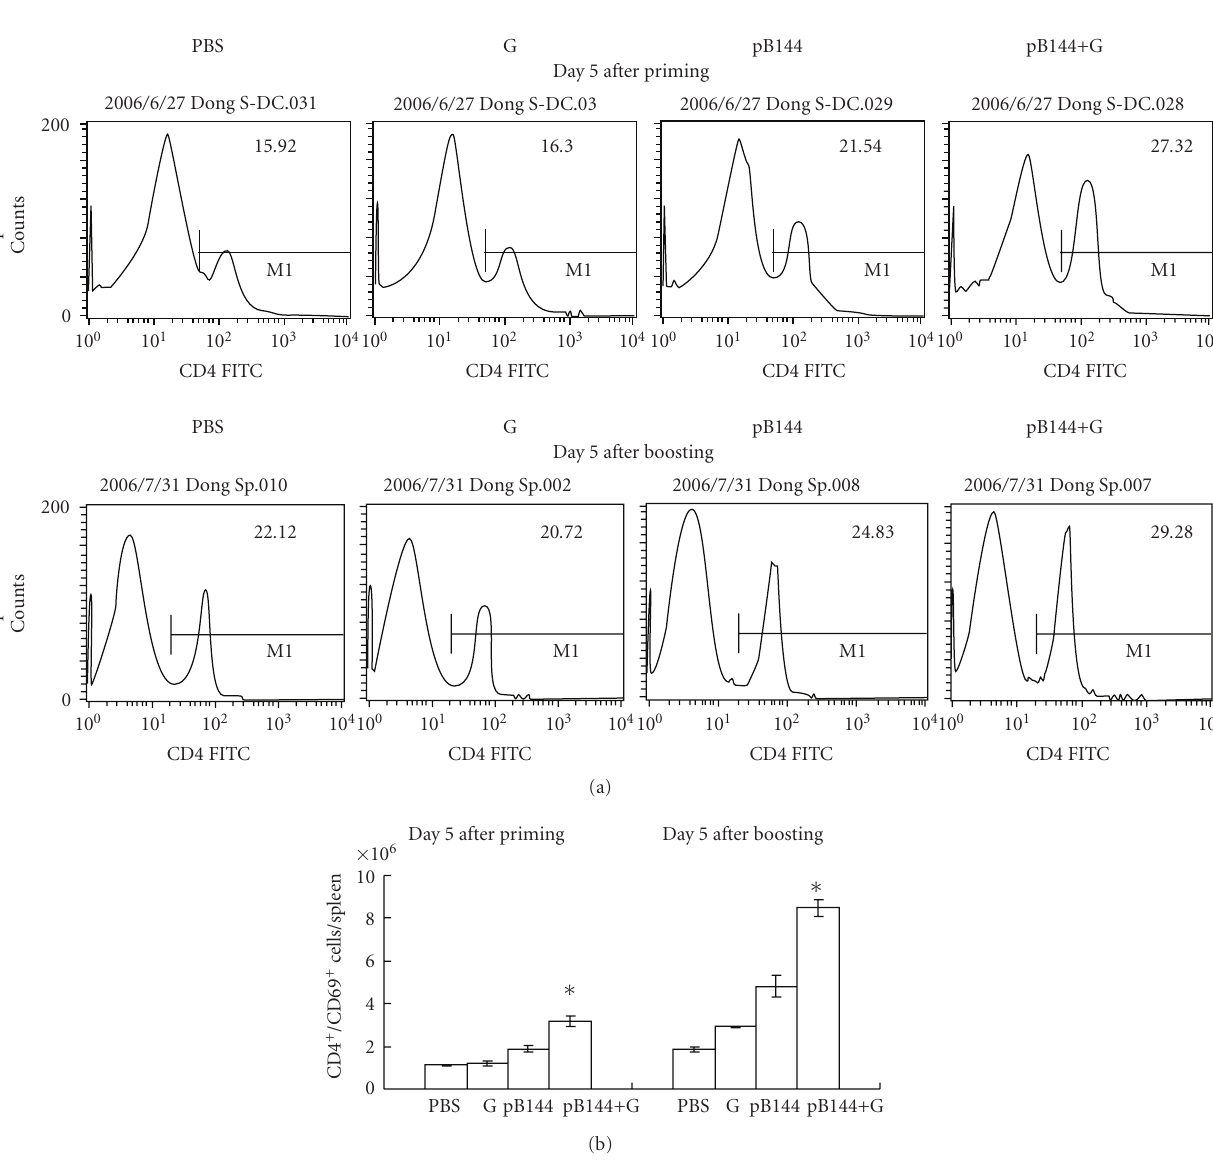
Figure 2: E ff ect of β -glu6 on pB144-induced recruitment and activation of CD4 + T cells in the spleen. Mice were immunized with β -glu6 (G), pB144, pB144+G, or PBS as described in Section 2. Five days after priming and five days after boosting, the percentage of CD4 + T cells (a) and the number of CD4 + /CD69 + T cells (b) in the spleen were evaluated. Data are expressed as mean of 3 mice/group. ∗ P < . 05, pB144+G versus pB144